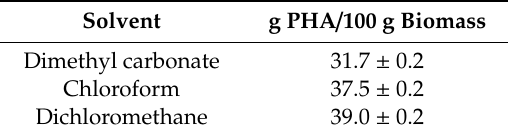
Table 2. Comparative extraction results for the different solvents. The reflux extraction of PHA with dimethyl carbonate at 1% biomass to solvent ratio for 1 h was compared with the reflux extraction with chloroform and with dichloromethane at the same solvent ratio and time. Values represent averages ± standard deviation of duplicates of g of PHA per 100 g of biomass.